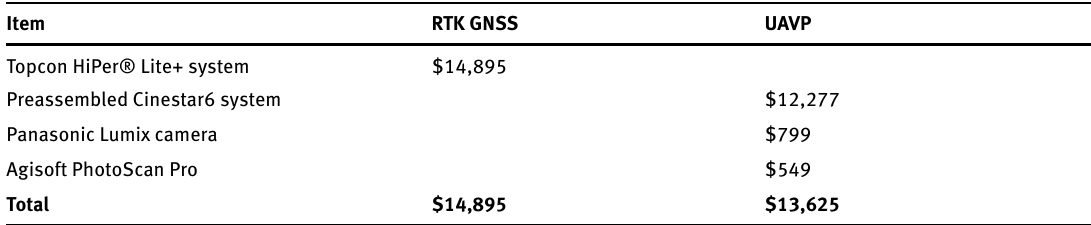
Table 4: Costs associated with RTK GNSS and UAVP survey in $US. Note that, aside from the camera, all other hardware and software costs reflect educationally discounted rates.